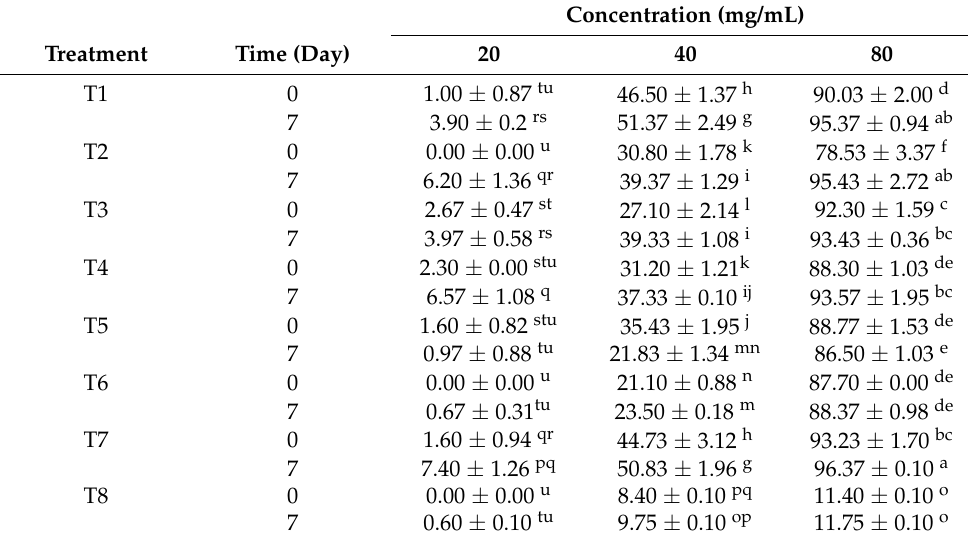
Table 4. Antioxidant activity as OH-scavenging (%) in peptide extracts from fermented milk samples after fermentation (day 0) and after 7 days of storage.